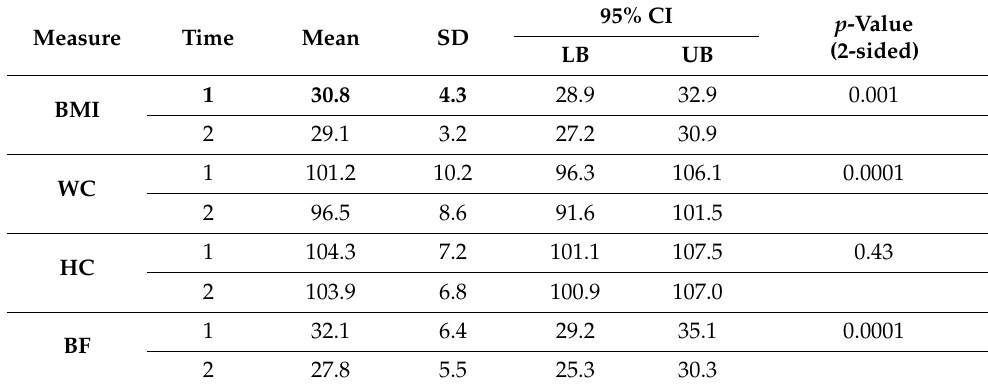
Table 2. Changes in anthropometric outcomes across